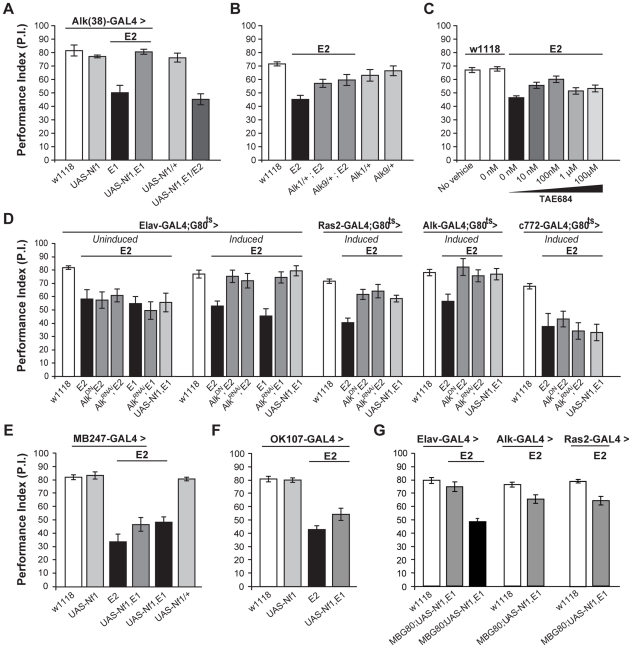
dAlk interacts with dNf1 to regulate learning.(A) Alk(38)-Gal4 expression of UAS-Nf1 in Nf1E1/E2 null mutants rescues learning. Heteroallelic Nf1E1/E2 mutant flies were used for ease of genetic manipulations. ANOVA indicated significant effects of genotype (F(5,40) = 20.36, p<0.0001, n≥6), whereas no significant differences between Alk(38)-Gal4 driven UAS-Nf1 in Nf1E1/E2 mutants and Alk(38)-Gal4/+ controls were found. (B) Alk1 or Alk9 heterozygous mutant alleles and Nf1E2 interact genetically to rescue learning. The performances of Alk1/+;Nf1E2, Alk9/+;Nf1E2 and Nf1E2 were significantly different (ANOVA: F(5,79)  = 8.78, p<0.0001, n≥12). (C) The Alk inhibitor TAE684 rescues Nf1E2 learning defects (ANOVA: F(6,81) = 18,60, p<0.0001, n≥10). Planned comparisons (shown in Table S3) showed significant differences between 0 nM and 10 nM or 100 nM concentrations. (D) Adult induced dAlk down-regulation pan-neuronally or in Ras2- and Alk(38)- expressing cells rescues Nf1E2 learning defects. ANOVA indicated significant effects of Nf1E2 mutants expressing UAS-AlkDN or UAS-AlkRNAi when compared to Nf1E2 alone (F(6,55)  = 9.49, p<0.0001, n≥7 for Elav-Gal4;Gal80ts (‘Induced’), F(4,41) = 15.89, p<0.0001, n≥8 for Ras2-Gal4;Gal80ts, F(4,38) = 4.15, p<0.0078, n≥6 for Alk(38)-Gal4;Gal80ts respectively). No rescue is observed upon bearing but not expressing the transgenes pan-neuronally (‘Uninduced’), or using the MB-specific c772-Gal4;G80ts driver. (E) Over-expression of a wild-type dNf1 transgene (UAS-Nf1) in the MBs using MB247-Gal4 fails to restore learning in Nf1 mutants. ANOVA indicated significant effect of genotype (F(5,46)  = 23.31, p<0.0001, n≥7 for all genotypes). Planned pairwise comparisons indicated significant differences between Nf1E2 mutant flies harboring the MB247-Gal4 driver, UAS-Nf1 transgene, or mutant flies overexpressing the wild-type dNf1 transgene in the MBs and heterozygous driver controls (p<0.0001 for all comparisons). (F) Over-expression of a wild-type dNf1 transgene (UAS-Nf1) in mushroom body neurons using OK107-Gal4 during development fails to restore performance of Nf1 mutants. ANOVA indicated significant effect of genotype (F(3,33)  = 37.72, p<0.0001, n≥8 for all genotypes). Planned pairwise comparisons indicated significant differences between Nf1E2 mutant flies harboring the OK107-Gal4 driver, or mutant flies overexpressing the wild-type dNf1 transgene in OK107-marked mushroom body neurons and heterozygous driver controls (p<0.0001 for all comparisons). (G) Pan-neuronal expression of a wild-type dNf1 transgene (UAS-Nf1) or in Alk- and Ras2- expressing neurons with the exclusion of the MBS restores learning in Nf1E1/E2 mutant flies. ANOVA indicated significant effect of genotype (F (6,66)  = 20.13, p<0.0001, n≥8 for all genotypes). Planned pairwise comparisons indicated significant differences between Nf1E1/E2 flies harboring the MB-Gal80 (MBG80) and UAS-Nf1 transgenes and mutant flies overexpressing the transgene pan-neuronally, as well as in Alk- positive and Ras2-positive cells excluding mushroom body neurons (p<0.0001). The performance of Elav;MBG80;UAS-Nf1,Nf1E1/E2 flies was not statistically different from their respective heterozygous driver control indicating full rescue (p = 0.26), contrary to the performance of flies overexpressing the transgene in Alk- positive and Ras2- positive cells, indicating partial rescue (p = 0.003 and p = 0.0003 for Alk(38)-Gal4 and Ras2-Gal4 respectively). Error bars denote S.E.M.